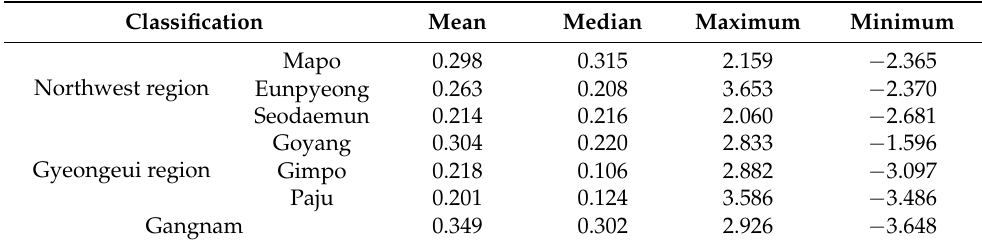
Table 2. Descriptive statistics of jeonse price change rate.